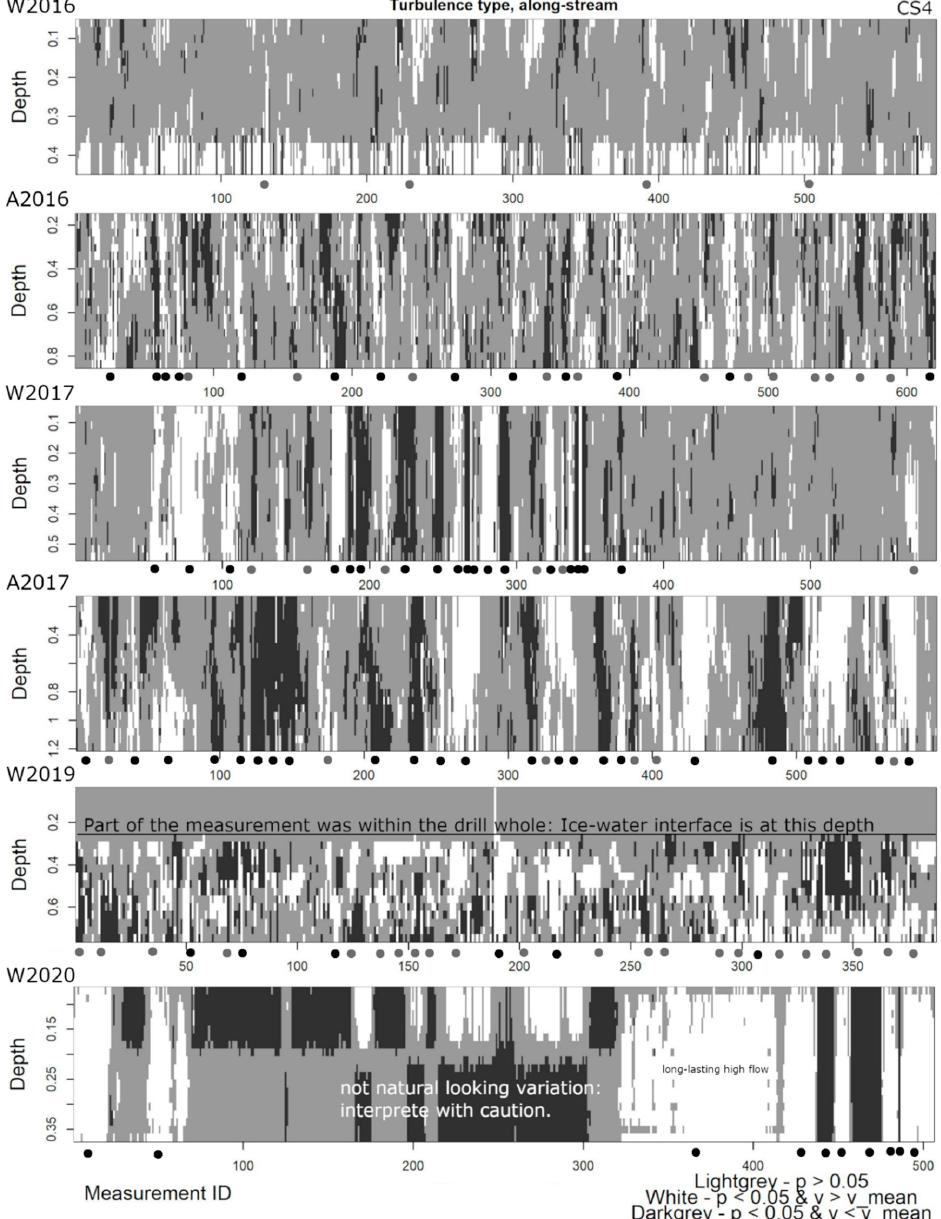
Figure 8. The results of the LISA analysis at CS4 during all measurement times based on streamwise velocity. The S2017 and W2018 results can be seen from Figures 3 and 4. Measurement ID means the sample numbers ( n ), and therefore also represents seconds. Note that the W2019 and W2020 measurements were shorter in time. The black dots indicate the occurrence times of statistically significant strong high and low flow wedges reaching from the surface to the riverbed, and the grey dots indicate the times when there is weaker wedge (i.e., cluster has broken with a few cells within the vertical water column). W2019 ice-water interface is marked in the figure.